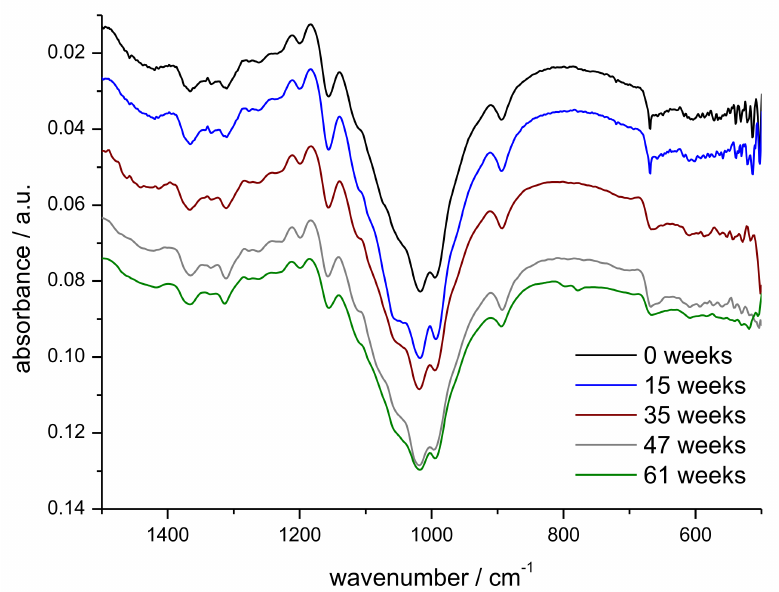
Figure 11. Zoomed-in section of the fingerprint region of theFTIR-ATR spectra of prototype 4 as function of exposure time in outdoor weathering (week 0, 15, 35, 47, 61).